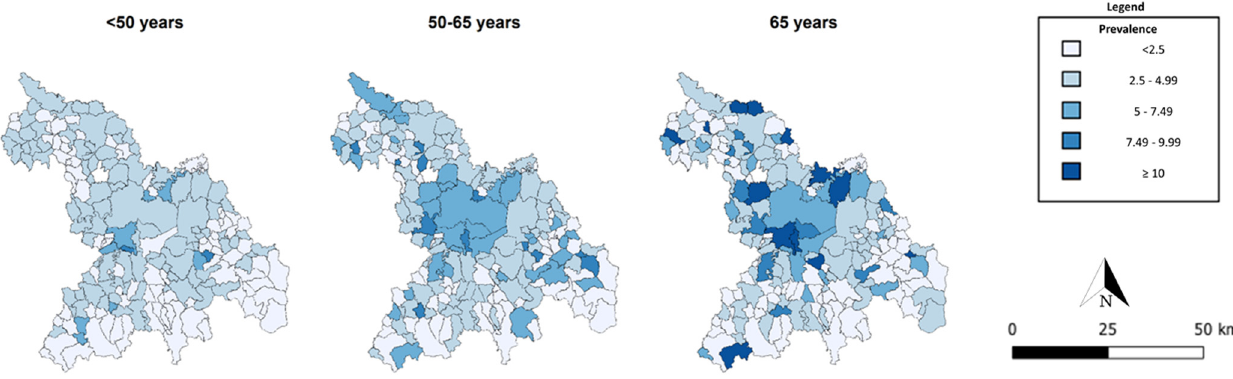
Figure A3. Choropleth maps of Alessandria LHA, divided by age. Colors represent the percentage of positive NP swabs divided by the population, in turn stratified by groups.